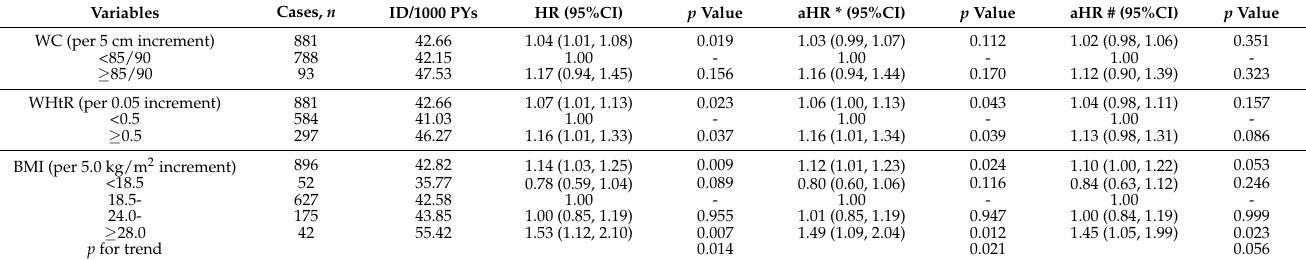
Table 2. Associations between baseline WC, WHtR, BMI, and the risk of incident